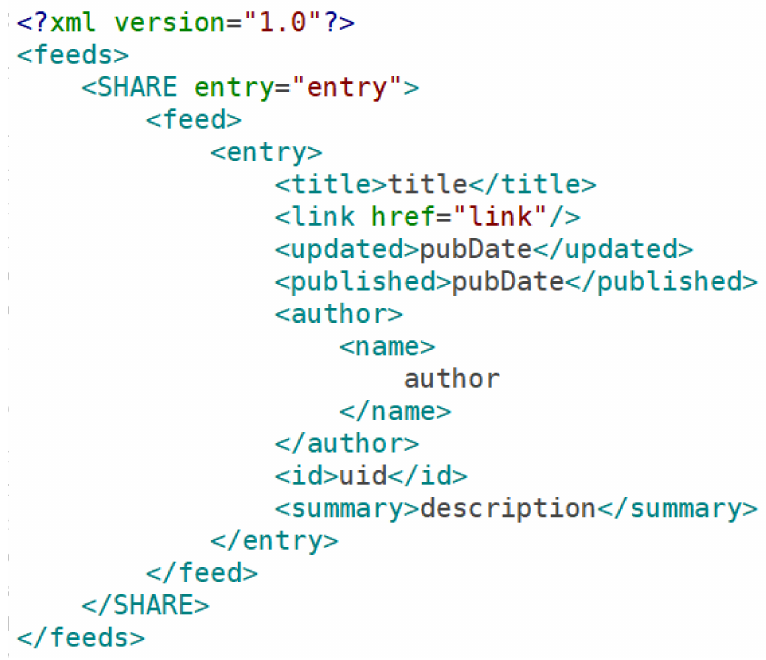
Figure 4. feedStructure.xml.